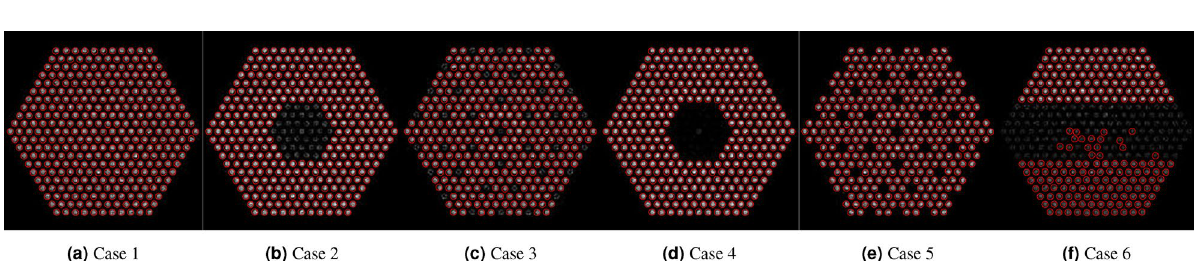
Figure 5. Image reconstructed using the inverse approach. Good contrast between the pin-present region and pin-absent region was achieved. No severe artifacts were observed on the reconstructed images.